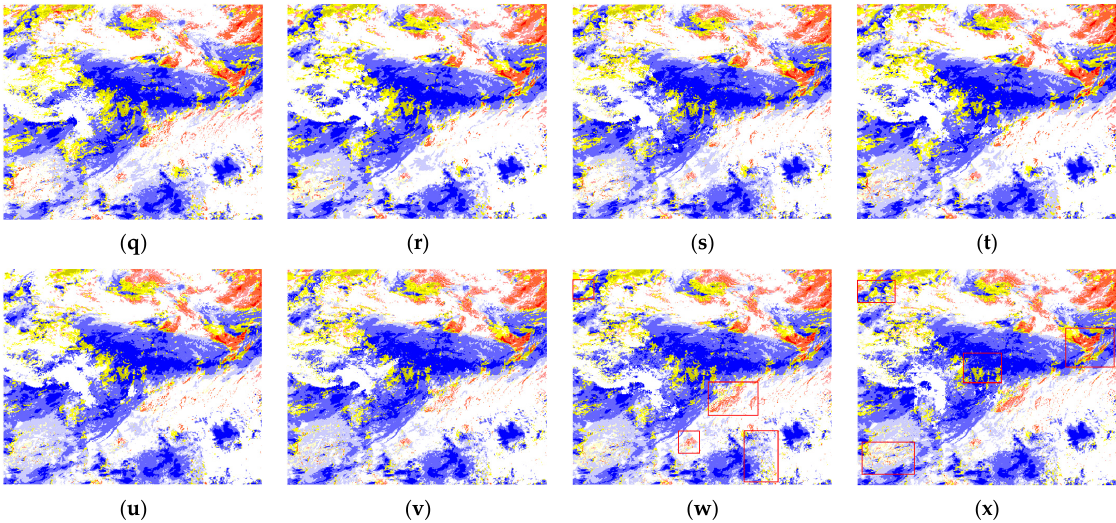
Figure 8. The visual comparison on CRMSCD at 3:30 on 11 July 2020 of ( a ) Original Image, ( b ) Ground Truth, ( c ) U-Net, ( d ) UNet3+, ( e ) SegNet, ( f ) DeepLabv3+, ( g ) GSCNN, ( h ) HRNetV2, ( i ) HRNetV2+OCR, ( j ) UCTransNet, ( k ) UATNet-S and ( l ) UATNet-B, and the visual comparison on CRMSCD at 3:30 on 18 July 2020 of ( m ) Original Image, ( n ) Ground Truth, ( o ) U-Net, ( p ) UNet3+, ( q ) SegNet, ( r ) DeepLabv3+, ( s ) GSCNN, ( t ) HRNetV2, ( u ) HRNetV2+OCR, ( v ) UCTransNet, ( w ) UATNet-S and ( x ) UATNet-B. The color corresponding to the label value is located in the lower right corner of Figure